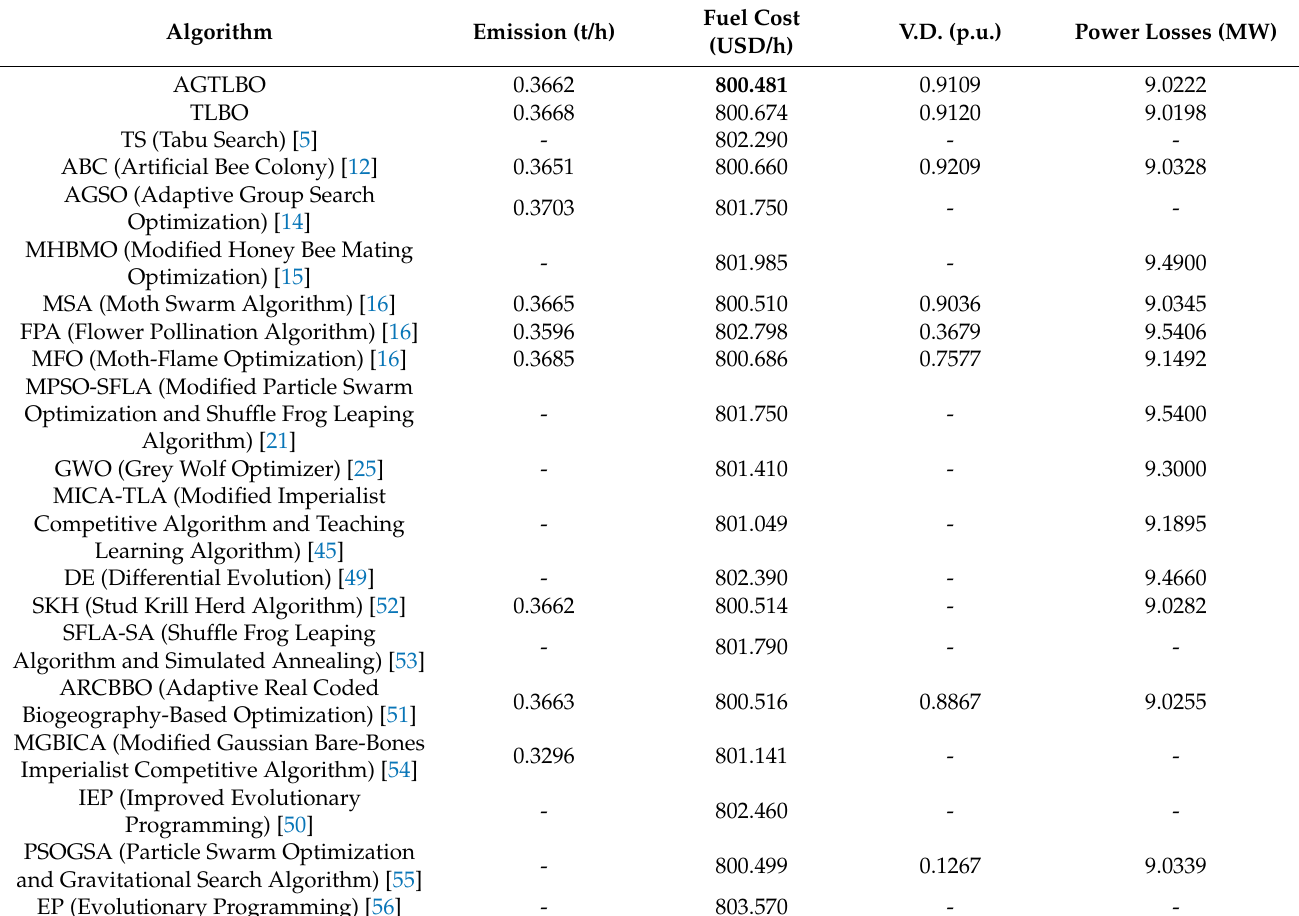
Table 2. Optimal results by different algorithms for Case